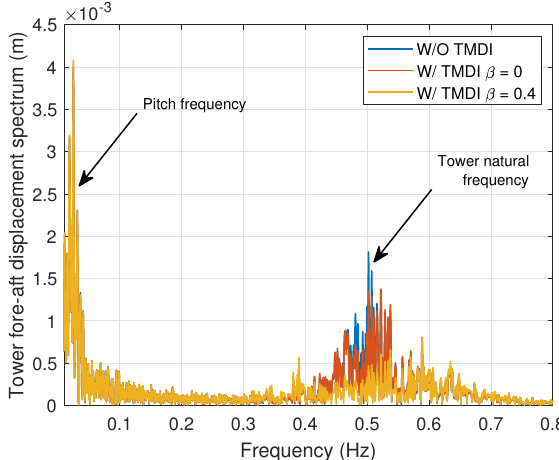
Figure 12. Tower fore-aft displacement